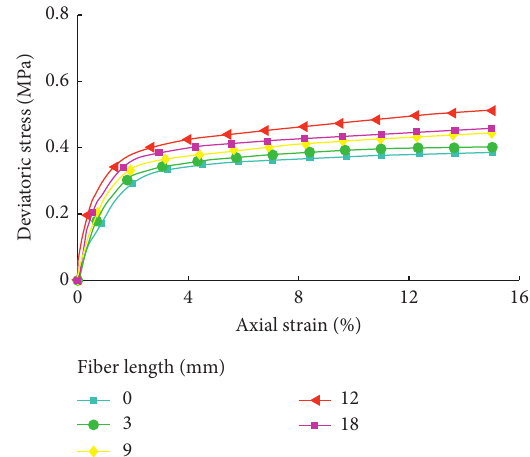
Figure 10: Deviatoric stress-axial strain of fiber-reinforced soil with different fiber length (confining pressure � 0.1 MPa; com- paction degree � 100; fiber content � 0.2%).